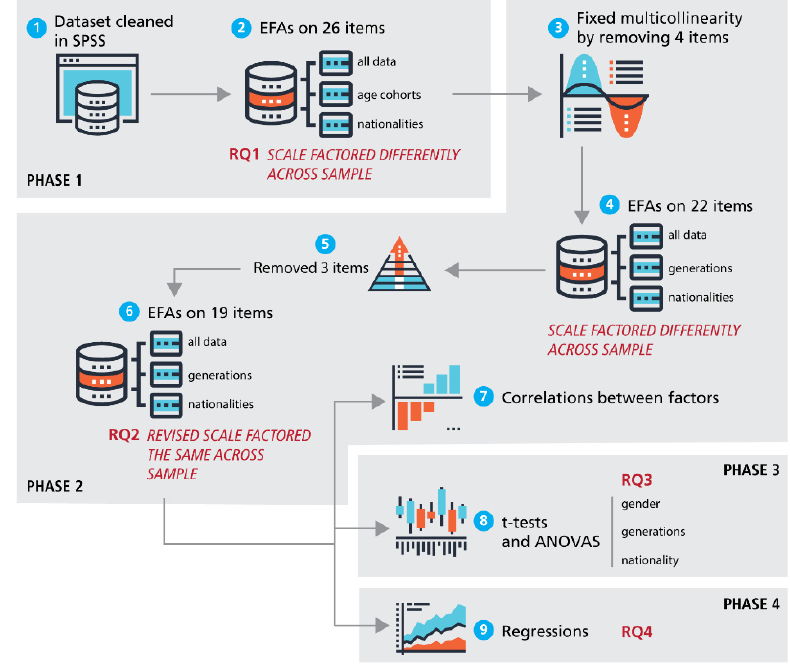
Figure 1. Analysis